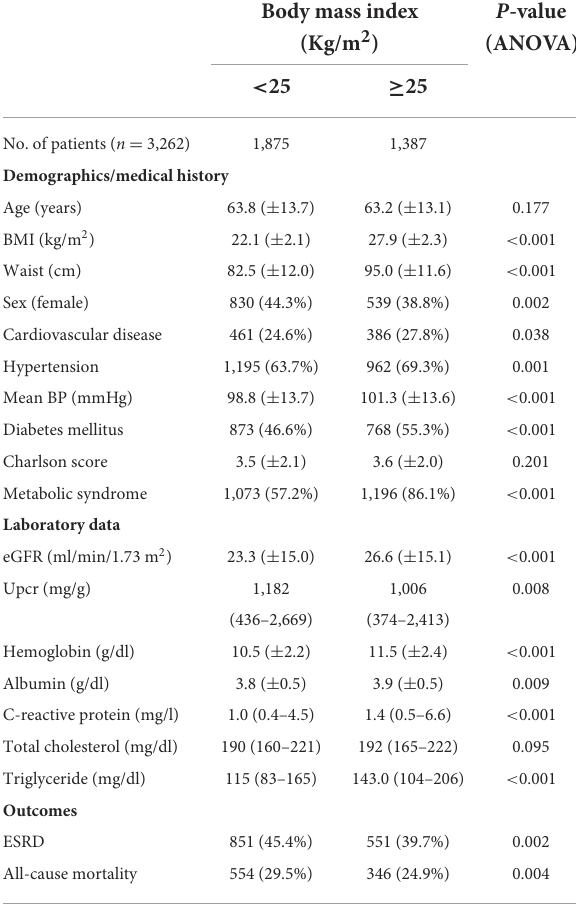
TABLE 1 Baseline characteristics of patients with stage 3–5 chronic kidney disease stratified by body mass